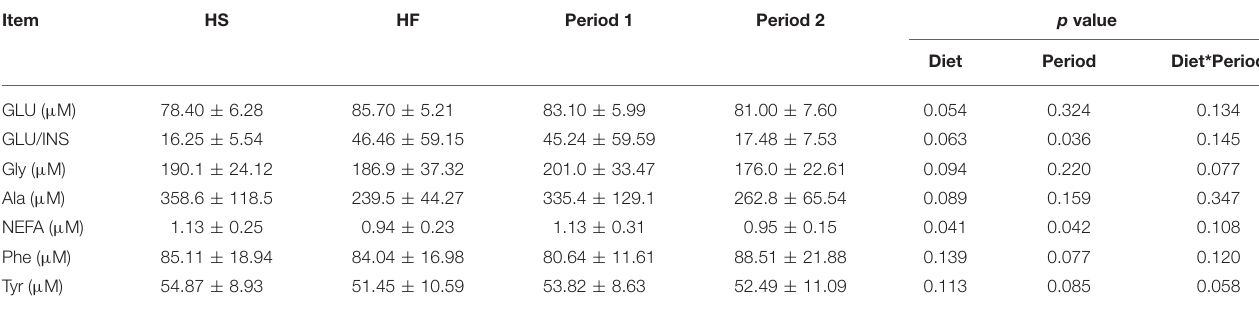
TABLE 2 | Blood parameters (significant findings; n = 5).